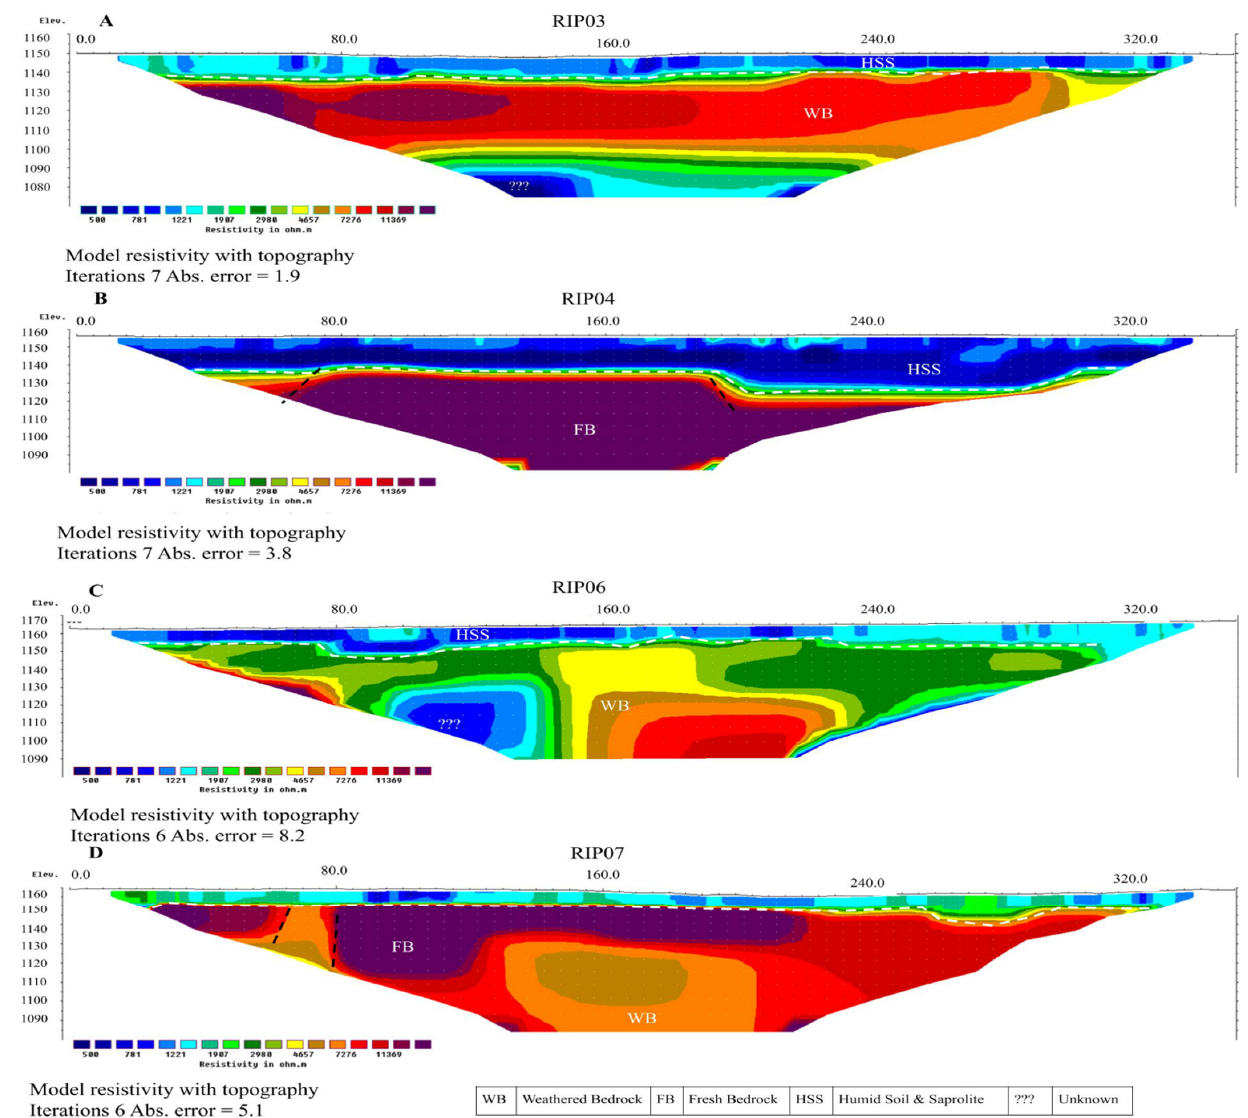
Figure 10. 2D resistivity models ( A – D ) in the region of Brasilia using the dipole-dipole array. The fractured zone’s shape and position in quartzite are delineated based on resistiv- ity contrast on the 2D resistivity models as shown in Figures 7B and 8A,D. At the top, the